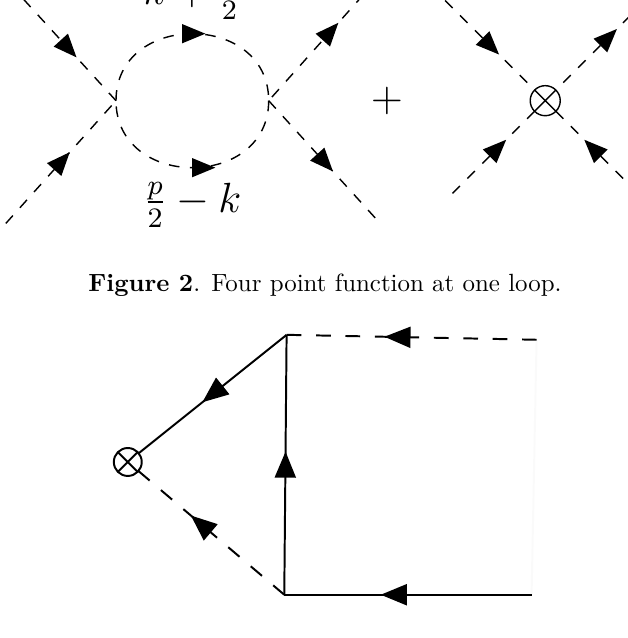
Figure 3 . One loop computation of scaling dimension of three-fermion boundary